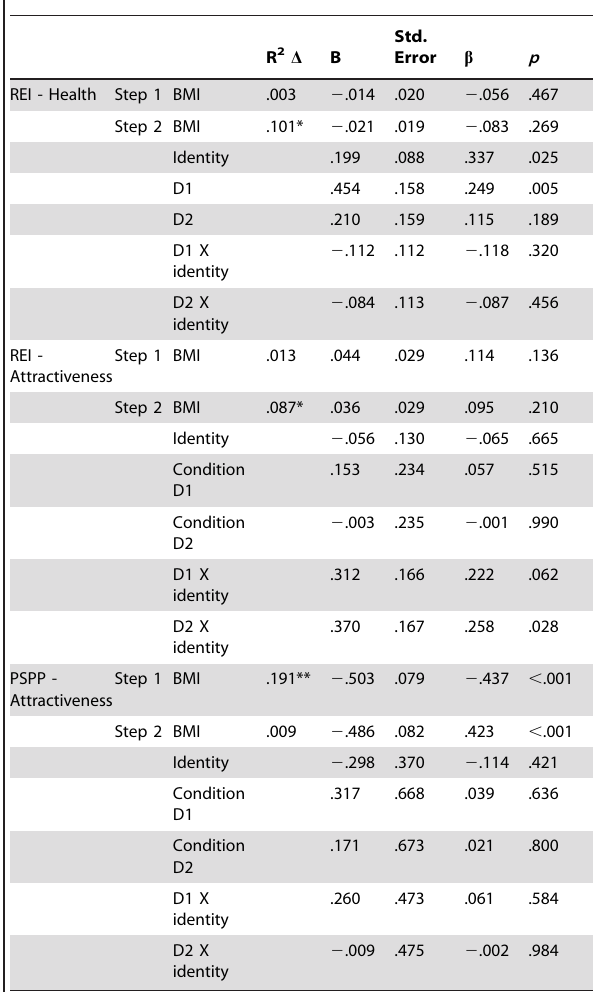
Table 2. Regression models predicting REI-Health, REI- Attractiveness, and PSPP-Attractiveness by experimental condition, exercise identity, and their interaction, also controlling for